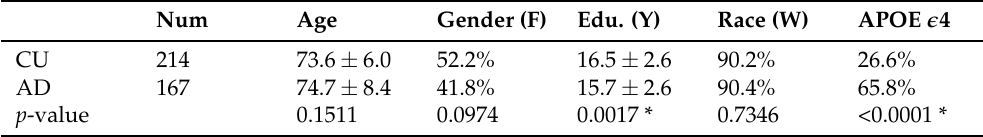
Table 1. Demographic of the study data. CU, cognitively unimpaired; AD, Alzheimer’s disease. Values are displayed as the mean ± SD . Asterisk (*) next to p -value indicates statistical significance.